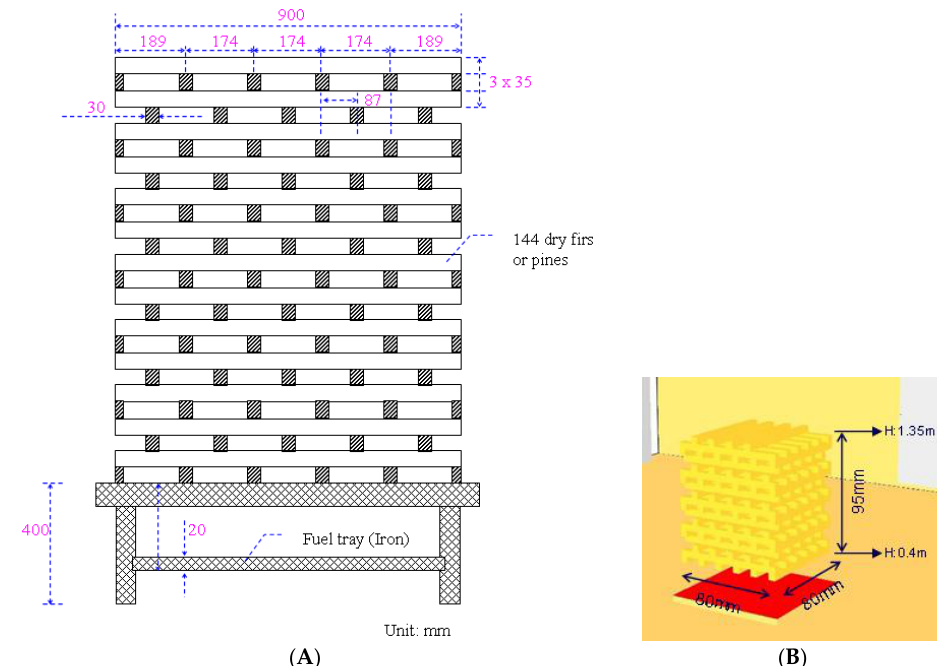
Figure 3. Heat release rate curve of wood model [40]. Table 3. Scenario description in the different simulation cases.